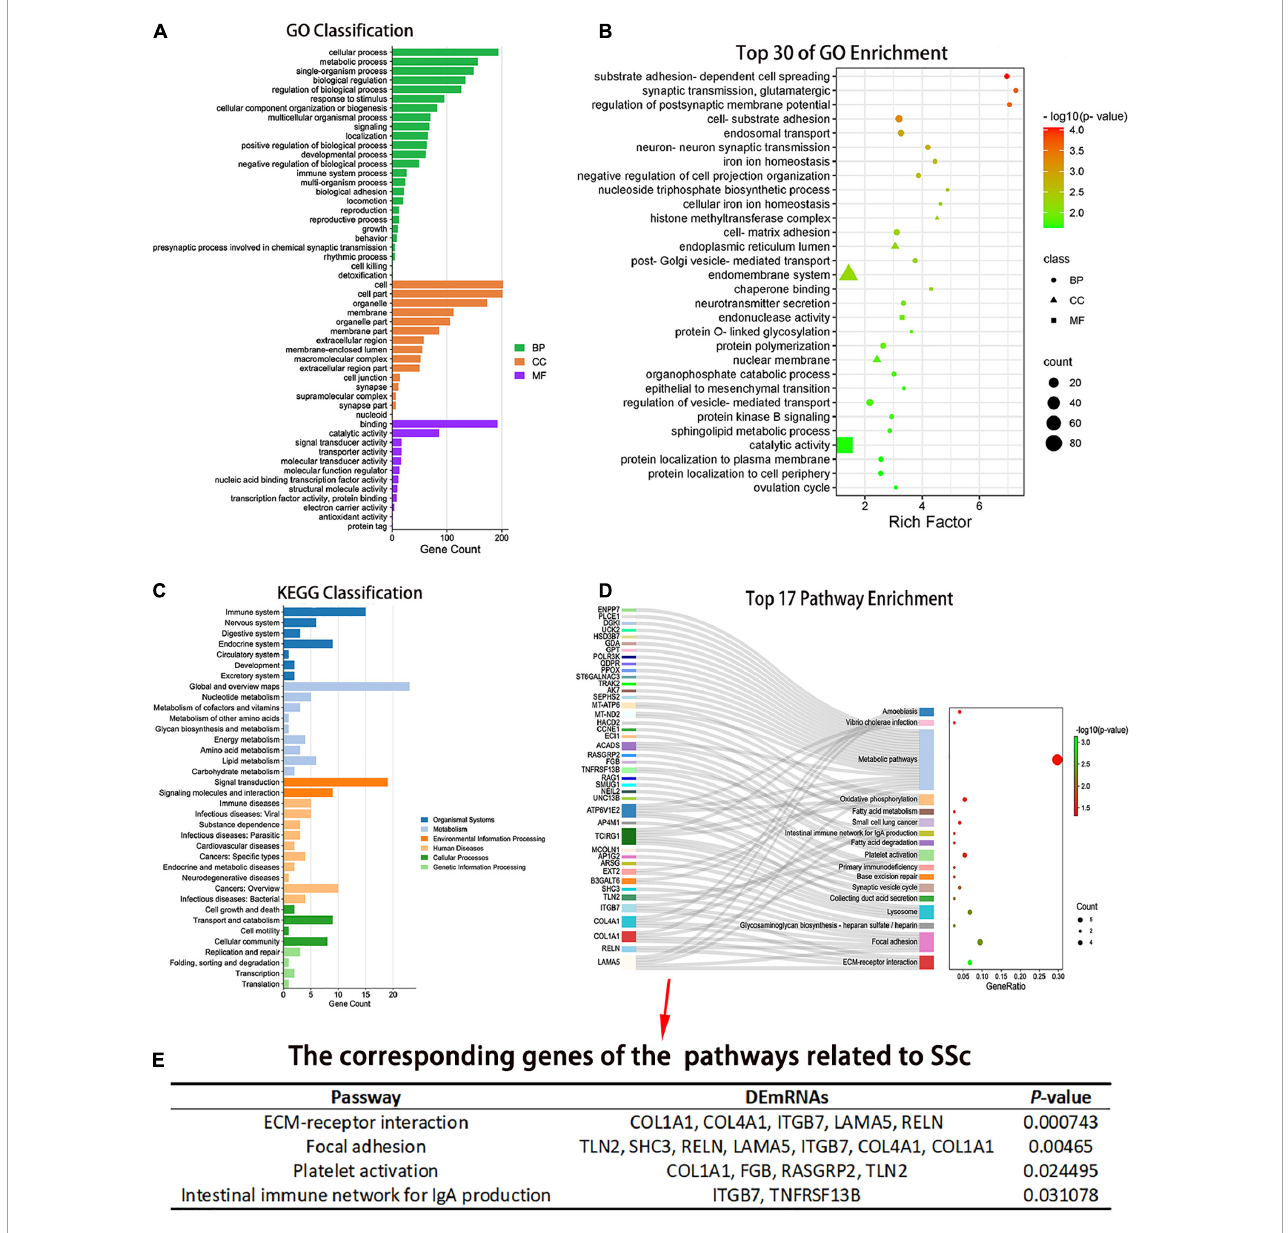
FIGURE4 Gene ontology (GO) and Kyoto Encyclopedia of Genes and Genomes (KEGG) enrichment analysis of the DEmRNAs. (A) The number of differentially expressed genes (DEGs) corresponding to the three GO levels, including biological process (BP), cellular component (CC), and molecular function (MF), was counted. (B) Top 30 GO entries with enrichment degree. The ordinate is the specific GO entry name. (C) KEGG classification. The abscissa is the number of genes mapped to a pathway class by DEGs, and the ordinate is the KEGG entries enriched by DEGs. (D) Pathway enrichment of the differential mRNAs. The abscissa is the proportion of genes corresponding to a certain pathway from the corresponding genes of all pathways. The ordinate is the KEGG entry name with P < 0.05 and the DEGs corresponding to the enrichment pathway. (E) Pathways related to SSc and corresponding genes with P < 0.05. GO, gene ontology; KEGG, Kyoto Encyclopedia of Genes and Genomes; BP, biological process; CC, cellular component; MF, molecular